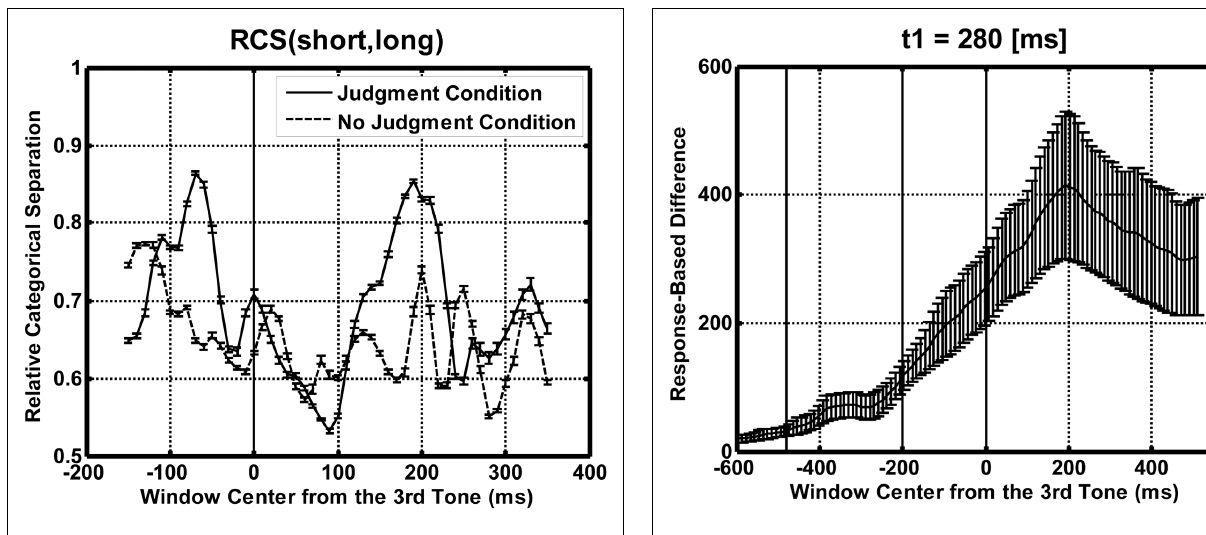
FIGURE 8 |The relative categorical separation (RCS) between short-duration ( t 1 = 80, 120, or 160ms) and long-duration ( t 1 = 240, 280, or 320ms) patterns is plotted as a function of the temporal position of the time-window center for each condition. Solid and dashed lines show the results for the judgment and the no-judgment condition, respectively.The “chance level” of the relative categorical separation is 0.6 assuming a homogeneous variance across the temporal patterns. Error bars represent the SE estimated by bootstrapping ( N = 30).